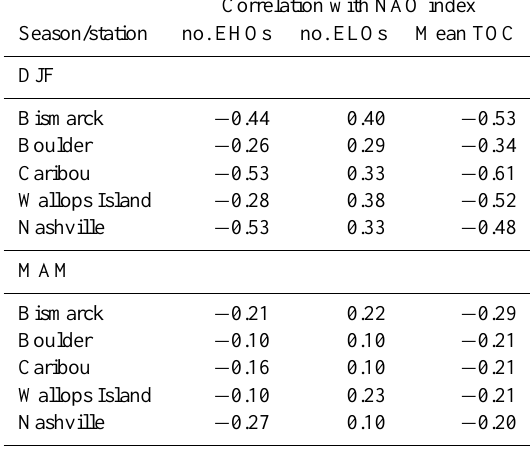
Table 1. Correlation of the NAO index and the average number (no.) of EHOs and ELOs and mean column ozone (TOC) on a seasonal basis at the five US long-term total ozone monitoring